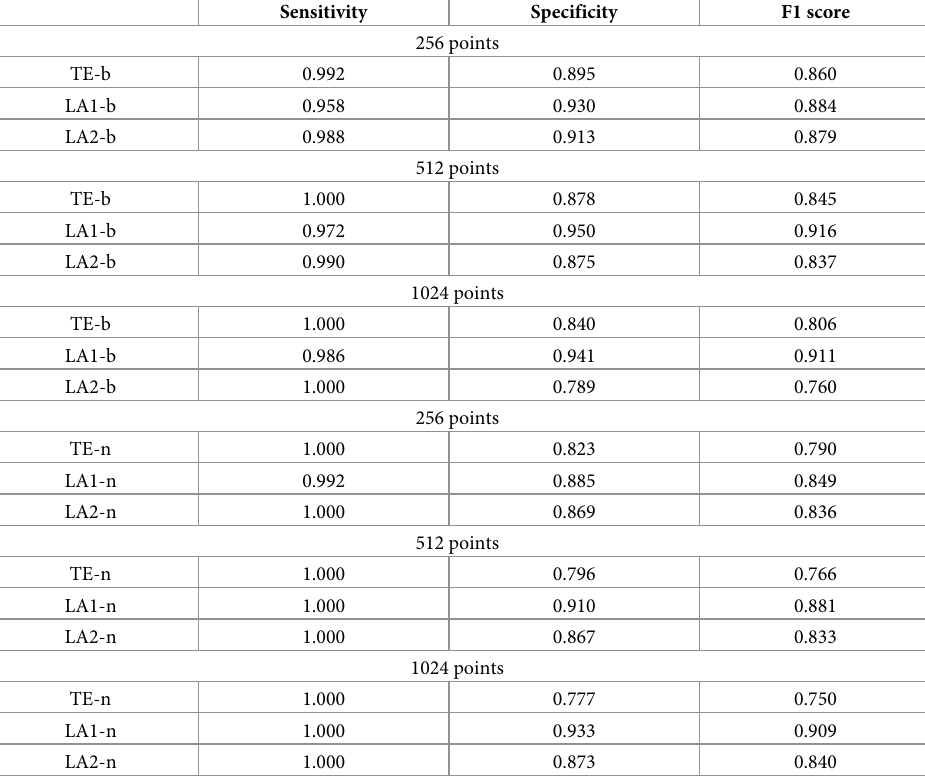
Table 4. Sensitivity, specificity and F1 score values obtained from Model D by binning(-b) and NN(-n)